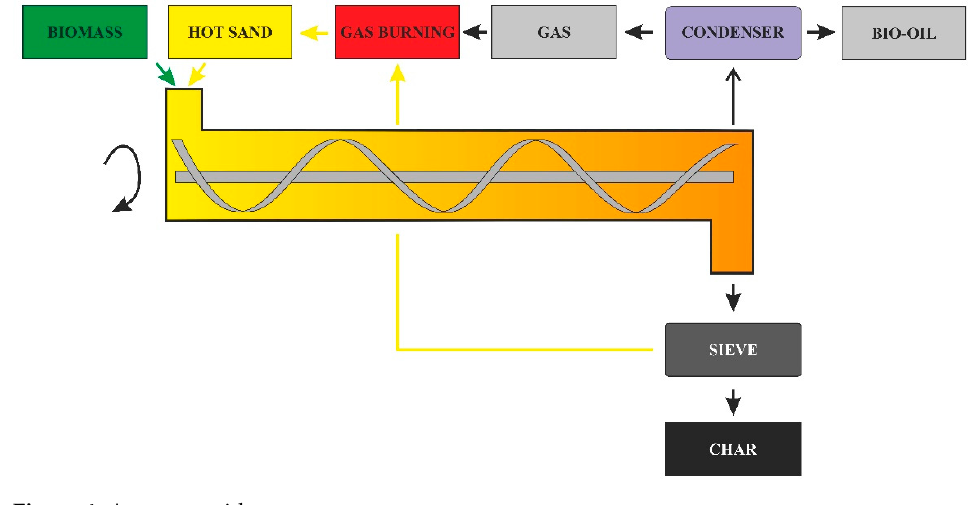
Figure 4. A reactor with a screw conveyor.